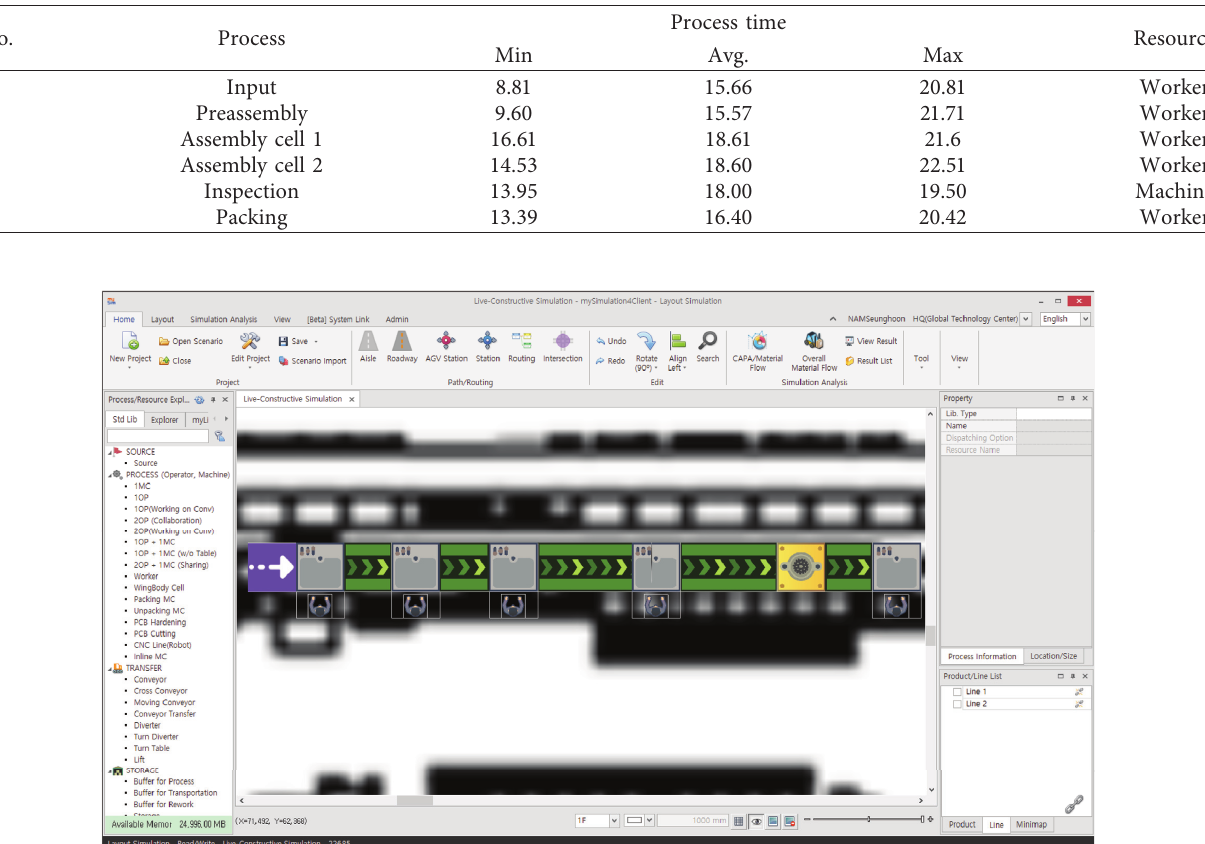
Figure 10: Layout for production line used in case study. Table 2: Process time and resource by process in the production line of the case study.